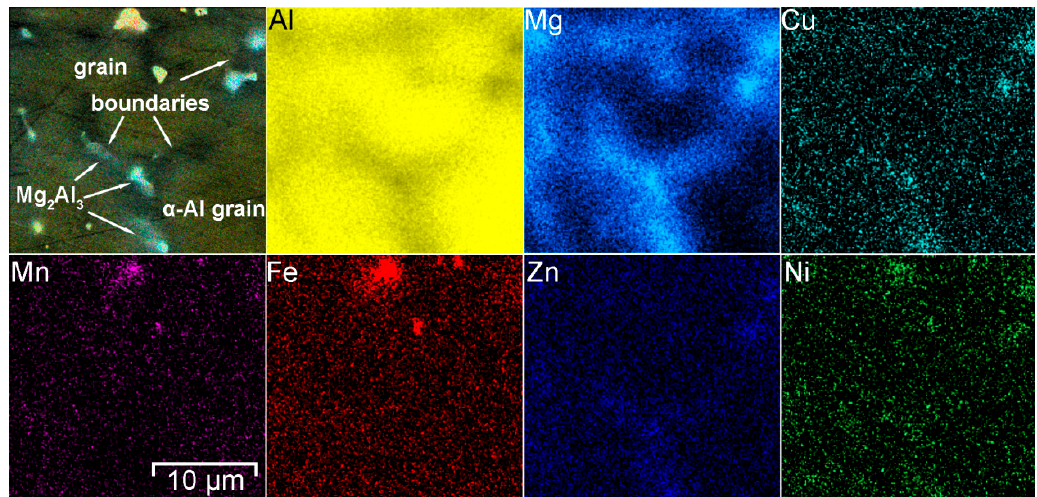
Figure 5. SEM-EDX study of the grain boundary in HAZ. Presence of Mn-Fe-Al and Mg-Al phases was detected.